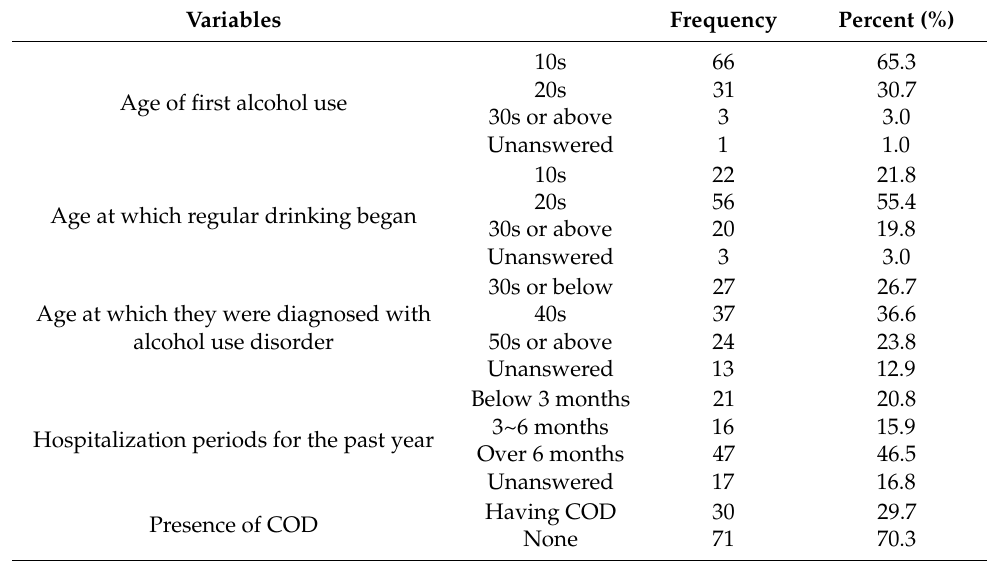
Table 1. Characteristics of participants ( N = 101).